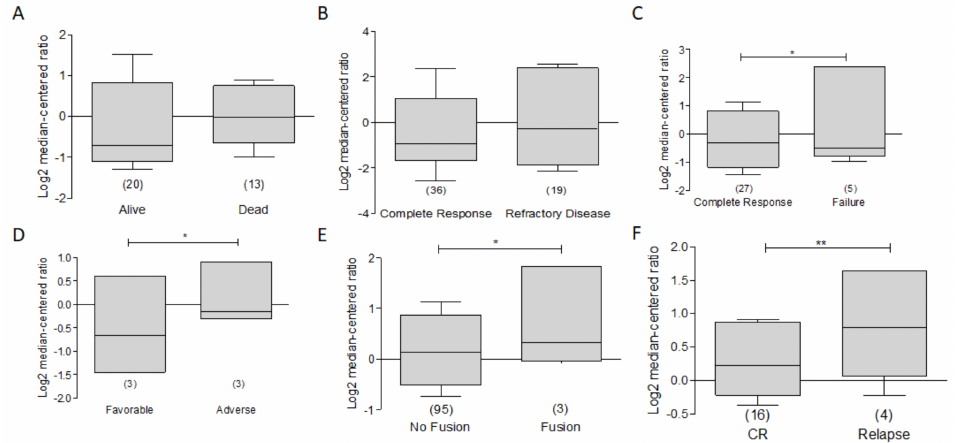
Figure 12. BCL-XL as a potential biomarker in Leukemia. ONCOMINE analysis of BCL-XL was revised and compared to clinical features of patients with Leukemia. ( A ) The dataset from the analysis conducted by Heuser [88] of BCL-XL expression was performed. A discrete increase was observed in dead patients. ( B ) In Bullinger’ leukemia dataset [89], a lower expression of BCL-xL was observed in patients with complete response vs. refractory disease. ( C ) Data from the study by Heuser is shown on responder vs. failure response patients (* p < 0.05). ( D ) In the same dataset lower expression of BCL-XL was related with a favorable outcome (* p < 0.05). ( E ) In the same dataset, the analysis of BCL-XL as a function of BCR-ABL is shown. ( F ) The expression of BCL-XL is shown in relapse patient vs. complete response patients (** p <